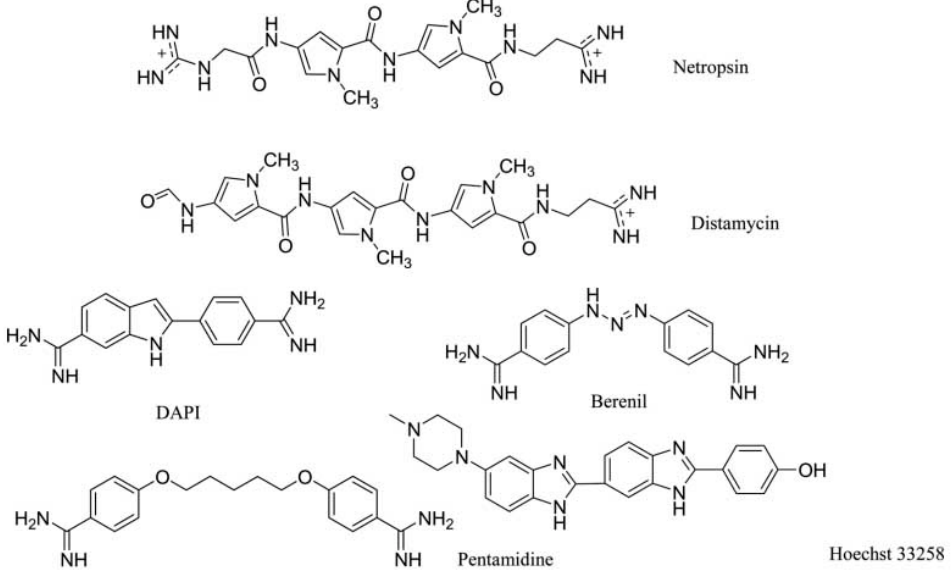
Figure 6. Typical structures of small molecules for DNA minor groove.